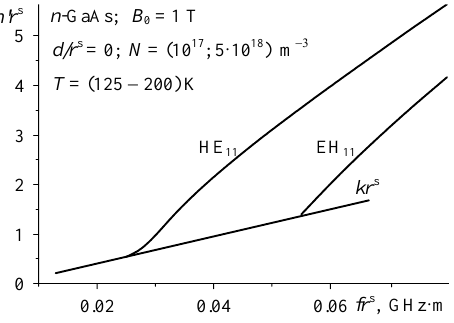
Fig. 3. Wave phase characteristics of models of gyroelectric n -GaAs semiconductor waveguides, when B 0 = 1 T; N = (10 17 –5·10 18 ) m –3 .